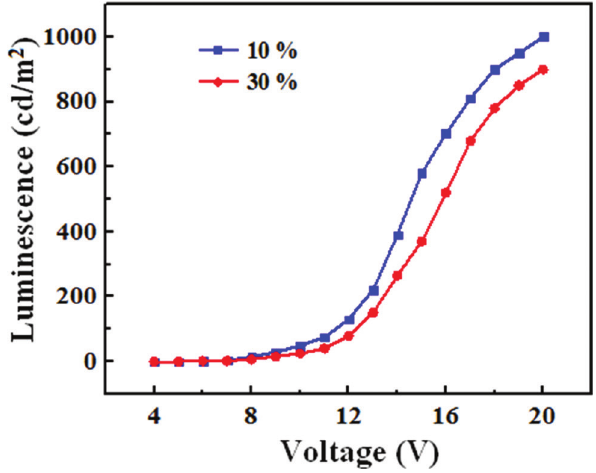
Figure 11: Luminance–current density characteristics of prepared OLED